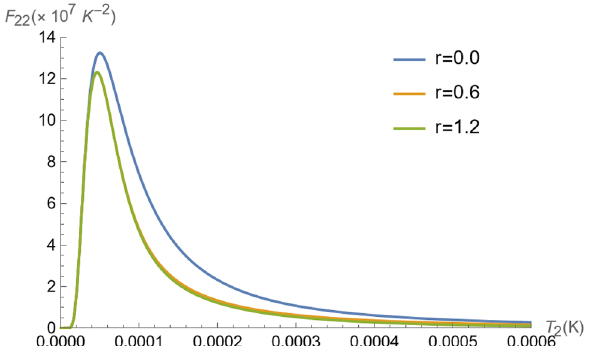
Figure 6. Fisher information F 22 as a function of parameter T 2 for θ = π/ 2 , and �/ 2 π = 4 MHz 37,57 . At θ = π/ 2 , all Fisher information becomes independent of T 1 since the ions have exchanged their states, and particularly, F 11 = F 12 = 0